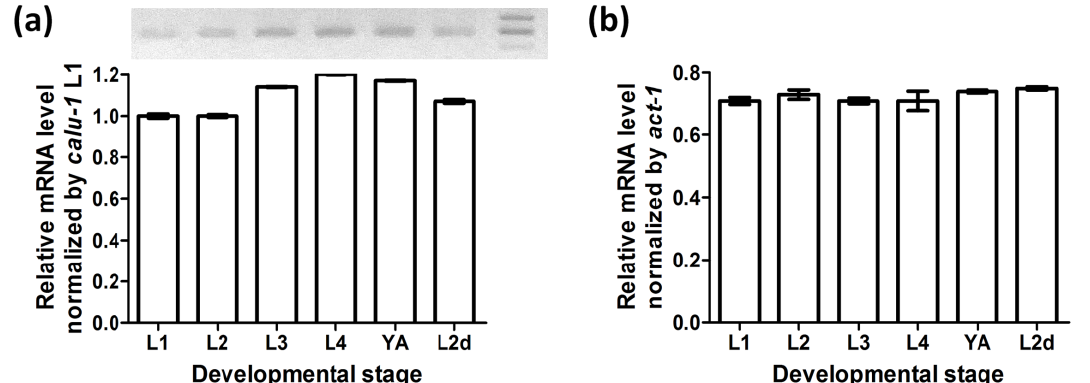
Figure 1. Expression of calu-1 at developmental stages. Three independent assays were performed using cDNA libraries generated from wild type N2 (L1, L2, L3, L4, and YA) or daf-2(e1370) mutants (L2d). ( a ) Relative mRNA level of calu-1 by L1 expression level to show differential expression levels of calu-1 at developmental stages. Representative gel image of quantitative real time RT-PCR is shown above the graph. Each well corresponds to a PCR product for each developmental stage. Size markers on the right of the image indicate 250, 200, and 150 bp from top to bottom. ( b ) Relative mRNA level of calu-1 normalized by internal control ( act-1 ). L1, first larval stage; L2, second larval stage; L3, third larval stage; L4, forth larval stage; YA, young adult stage; L2d, L2 predauer